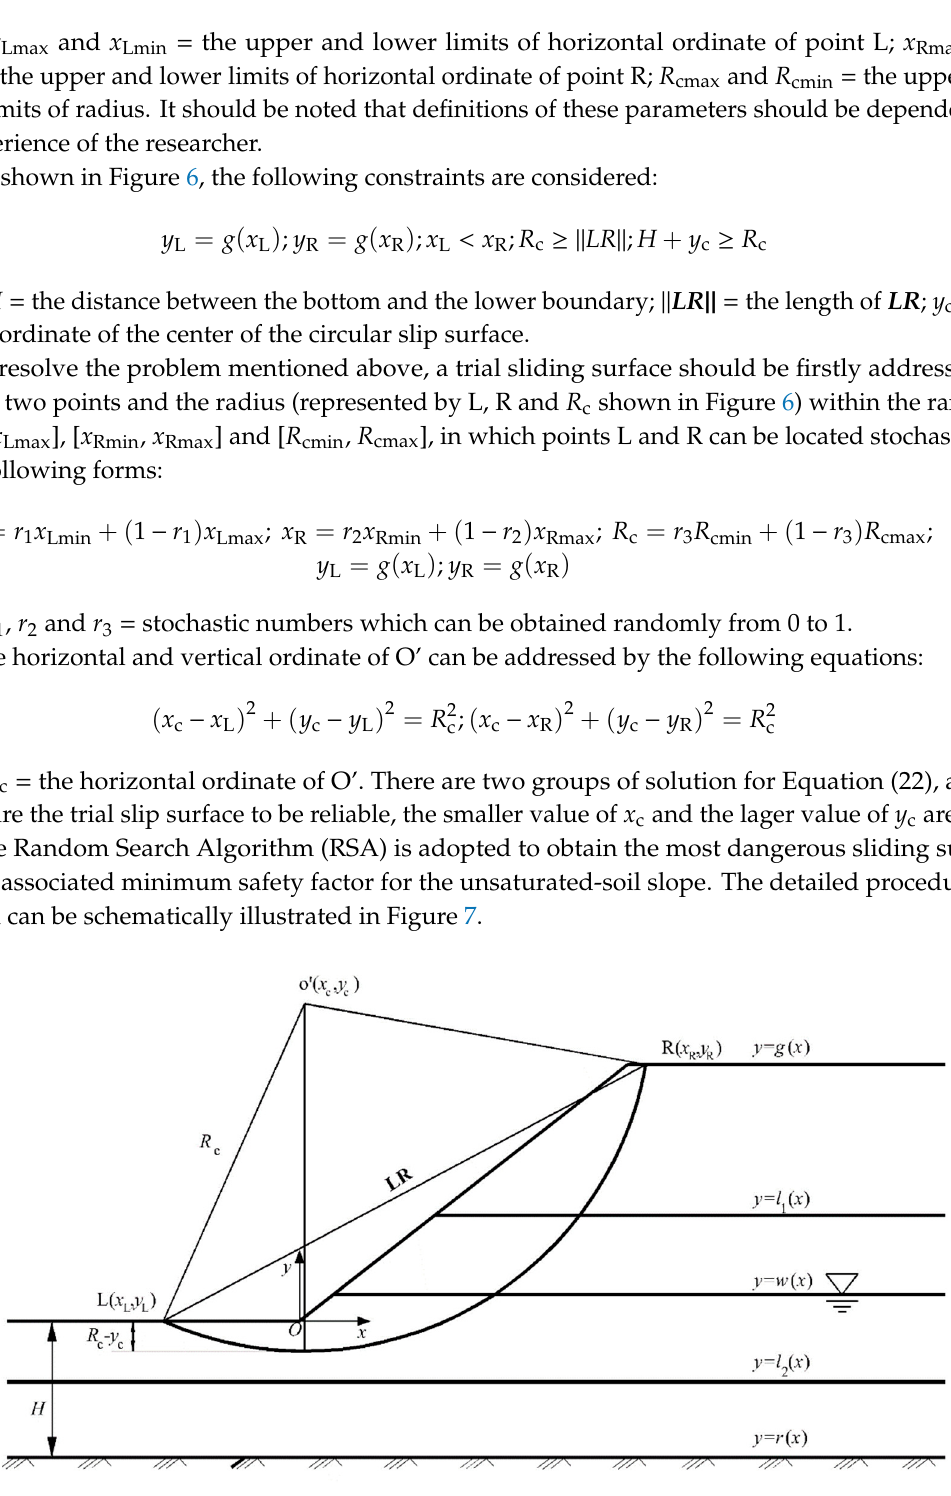
Figure 6. Cross section of a typical multilayered slope with circular sliding surface.